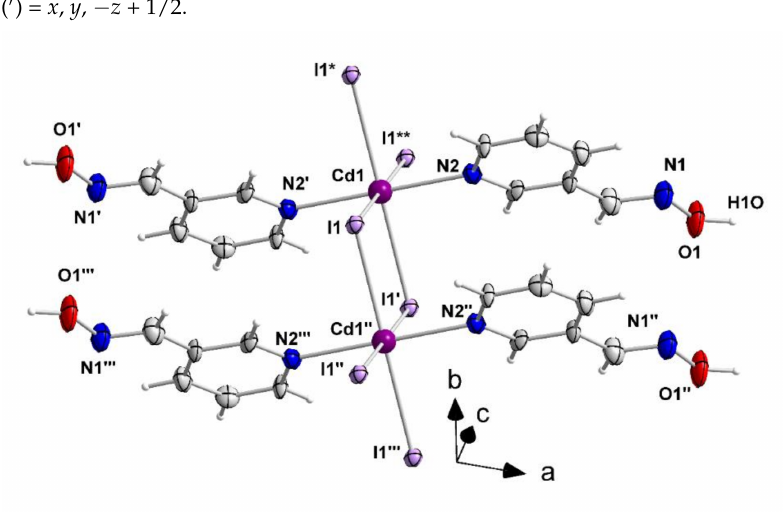
Figure 7. Cd II atoms, the donor atoms and the N, O atoms of the oxime groups are numbered.